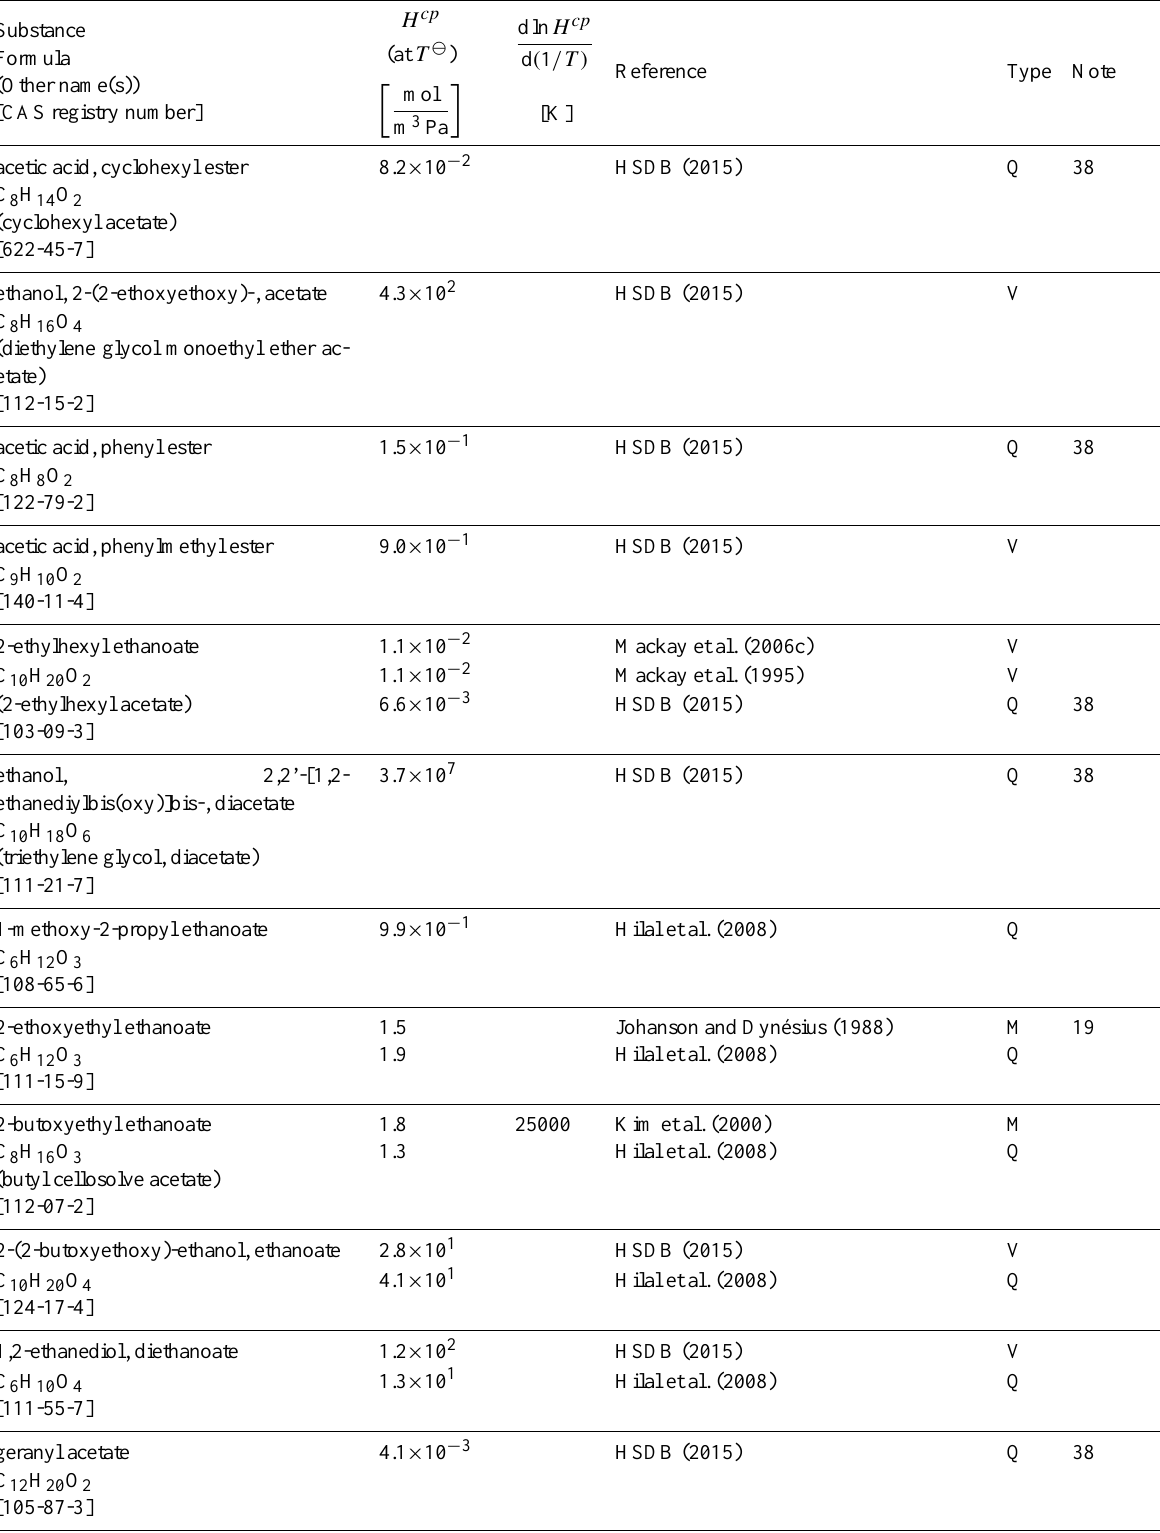
Table 6: Henry’s law constants for water as solvent